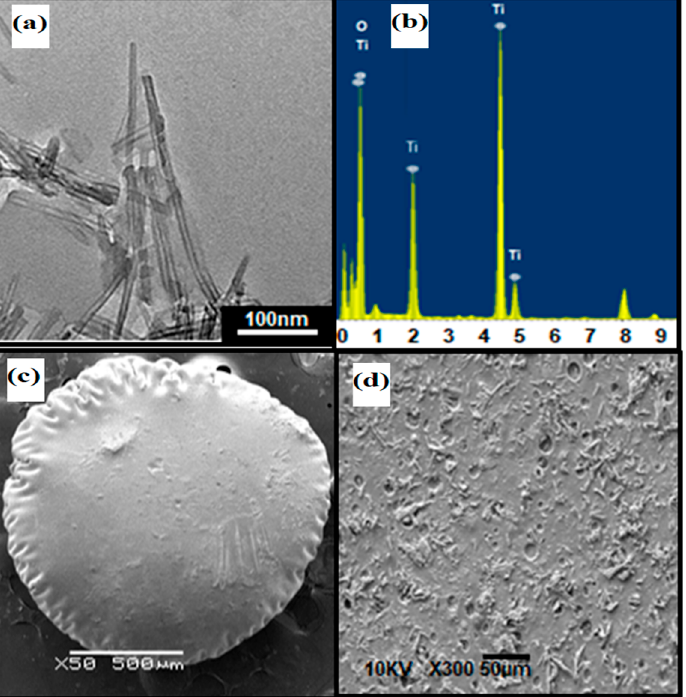
Figure 2. ( a ) TEM image of the TiO 2 nanotube and ( b ) EDS data of SA/PVP/TiO 2 nanocomposite. SEM micrographs of the ( c ) spherical-shaped bead and ( d ) higher magnification of bead’s